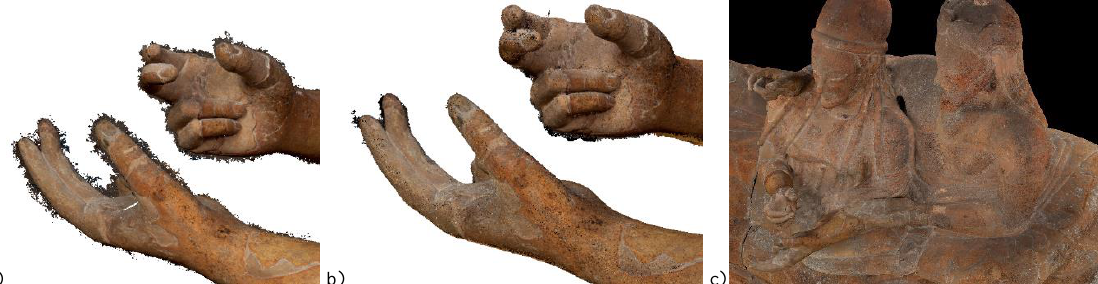
Figure 8. a) Noisy points generated from mixed pixels on boundaries. b) The erroneous points are reduced when all the images are used together. c) Particular of the photogrammetric textured 3D model.